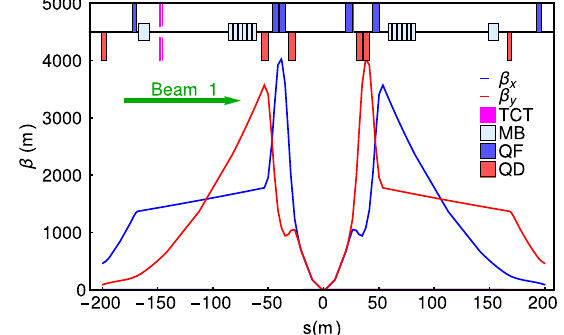
1. The β -functions around the ATLAS experiment in the LHC for the clockwise rotating beam (B1), calculated with MAD - X [7], shown together with the layout of dipoles (MB, main bend), horizontally focusing (QF) and defocusing (QD) quadrupoles, and tungsten collimators (TCTs) for protection of the aperture bottleneck. This optics [6] with β (cid:1) ¼ 60 cm was used in the 2012 physics run. The IP is located at s ¼ 0 and the beam direction is from left to right, meaning that the incoming beam passes the TCTs before the inner triplets and the IP. The optics is identical in CMS except that the horizontal and vertical planes are